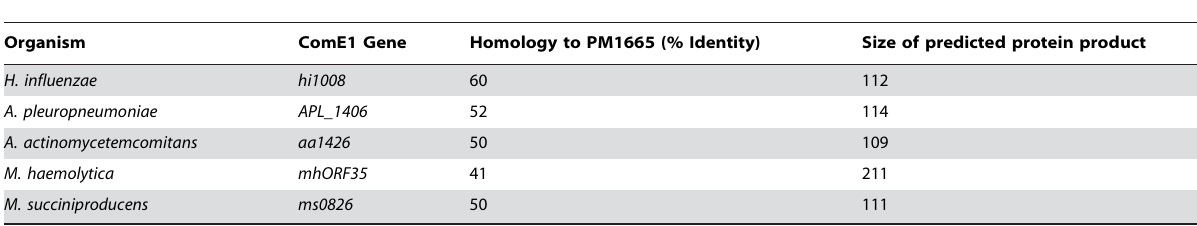
Table 2. Homologues of PM1665 (ComE1) from members of the Pasteurellaceae selected for cloning and expression.